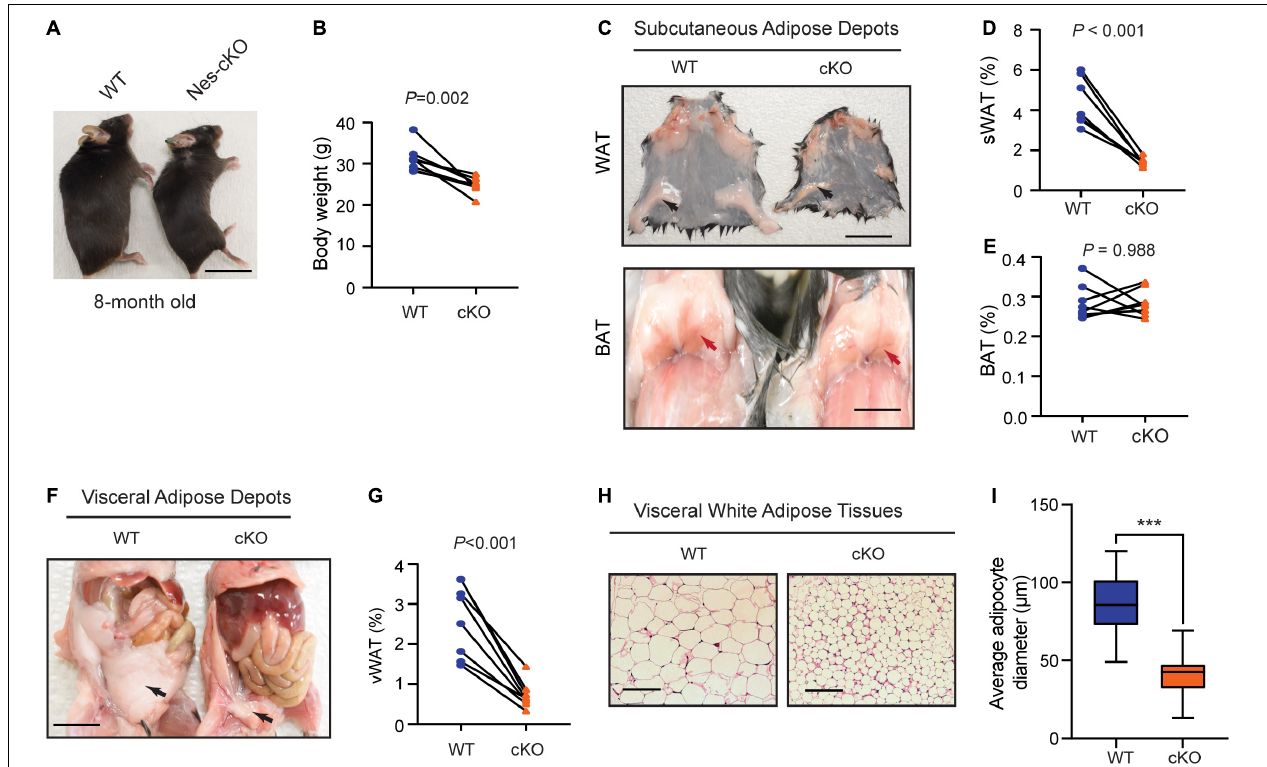
FIGURE 2 | Loss of Ash1l in the mouse brain reduces adipose tissue depots. (A) Representative photos showing the low body weight of adult Ash1l -Nes-cKO mice compared to wild-type littermates. (B) Plot showing the body weight of adult (8-month-old) wild-type and Ash1l -Nes-cKO mice. For each group, n = 8. P -values calculated using paired t -tests. (C) Photos showing subcutaneous white adipose depots (WAT) and brown adipose deports (BAT) in wild-type and Ash1l -Nes-cKO adult mice. Bar = 0.5 cm. (D,E) Plots showing the quantitative measurement of subcutaneous white adipose depots (sWAT) and brown adipose depots (BAT) in wild-type and Ash1l -Nes-cKO mice. Y-axis represents the percentage of subcutaneous adipose tissue normalized to total body weight. For each group, n = 8. P -values calculated using paired t -tests. (F) Representative photos and showing the visceral white adipose depots in wild-type and Ash1l -Nes-cKO mice. Bar = 0.5 cm. (G) Plots showing the quantitative measurement of visceral white adipose depots (vWAT) in wild-type and Ash1l -Nes-cKO mice. Y-axis represents the percentage of visceral adipose tissue normalized to total body weight. For each group, n = 8. P -values calculated using paired t -tests. (H) Photos showing the adipocytes of visceral white adipose tissues under microscope. Bar = 50 µ m. (I) Plot showing the average diameters of adipocytes of wild-type and Ash1l -Nes-cKO mice. For each group, n = 30. P -values calculated using unpaired t -tests. *** p < 0.001.